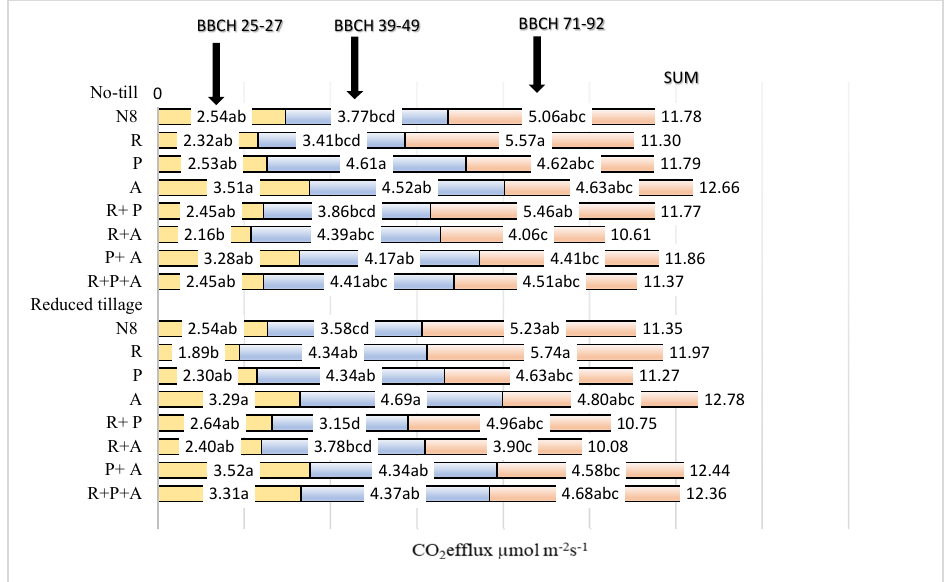
Figure 3. The influence of biostimulants on soil CO 2 emissions at the beginning, middle, and end of the vegetation period (2020). N8—compensatory nitrogen at 8 kg per ton of straw, without biological preparations; R— Ruinex 1 L ha −1 ; P— Penergetic k 0.2 L ha −1 ; A— Azofix 1 L ha −1 ; R + P— Ruinex 1 L ha −1 + Penergetic k 0.2 L ha −1 ; R + A— Ruinex 1 L ha −1 + Azofix 0.5 L ha −1 ; P + A— Penergetic k 0.2 L ha −1 + Azofix 1 L ha −1 ; R + P+A— Ruinex 1 L ha −1 + Penergetic k 0.2 L ha −1 + Azofix 0.5 L ha −1 . The averages of treatments marked with different letters (a, b, c ...) denote a significant influence of biostimulants and their mixtures; nonsignificant difference p > 0.05.